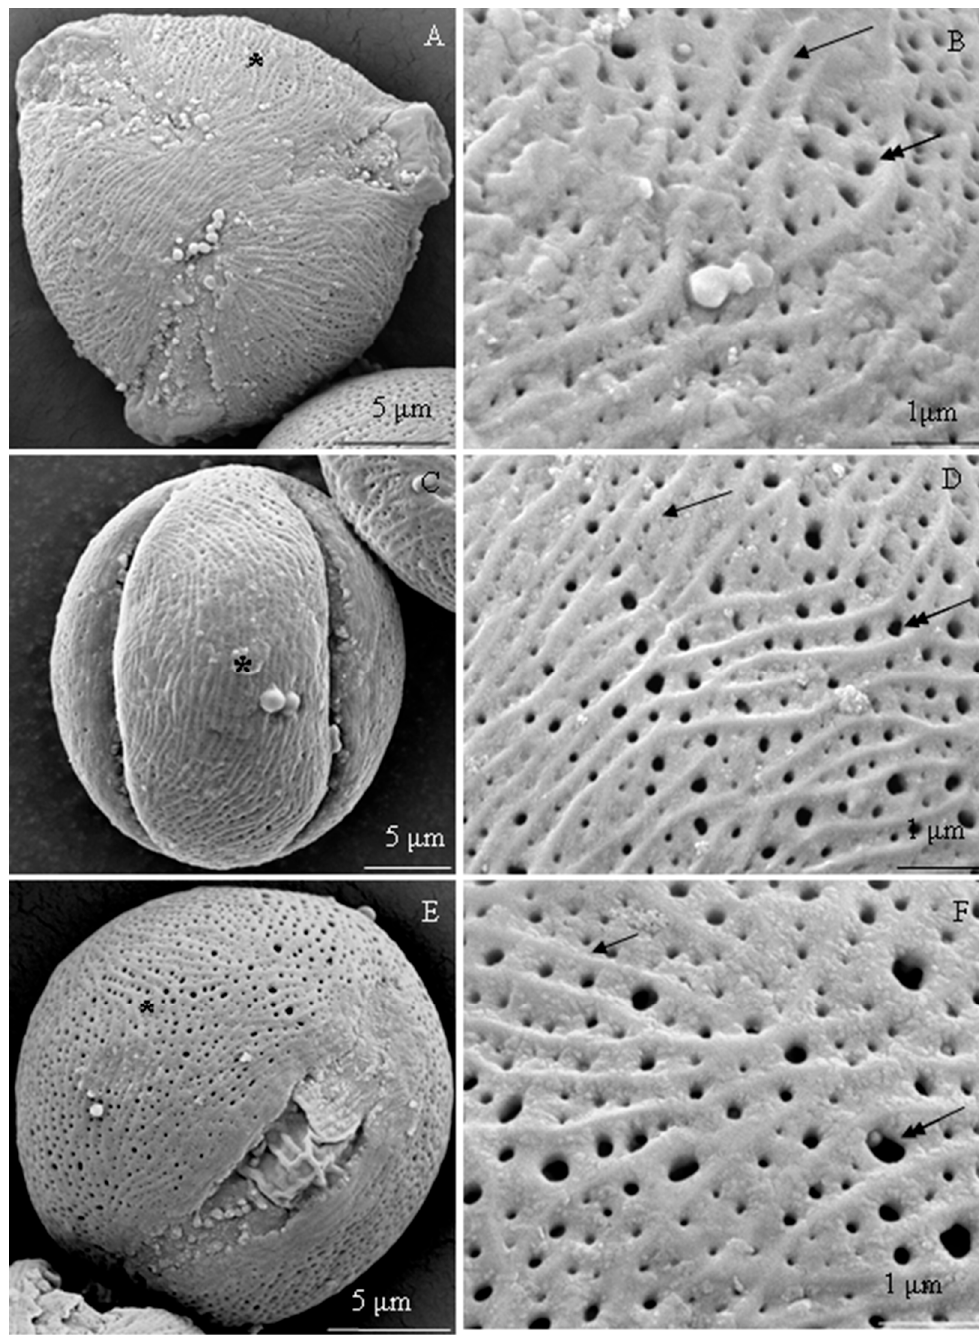
Figure 2. A – F . Pollen grains ( A , C , E ) and fragments of exine surface sculpture ( B , D , E ) in Rubus idaeus ‘Laszka’: A , B —polar view, ( A ) pori visible in colpi, striated surface sculpture and perforations, ( B )—striated exine surface, different distances between muri (arrow), perforations with different diameters (double-headed arrow) in colpi between muri; C , D —equatorial view, visible muri arranged in parallel and along the polar axis with an undulating or semicircular curve; numerous perforations in colpi, ( D ) muri (arrow) arranged in parallel or in an arcuate curve, dense distribution of perforations (double-headed arrow) in colpi, different diameters of perforations; €—colpus extending to the poles, numerous perforations visible in the exine; ( F) —perforations (double-headed arrow) arranged in rows in colpi, visible differences in the diameter of perforations. A – F - SEM.